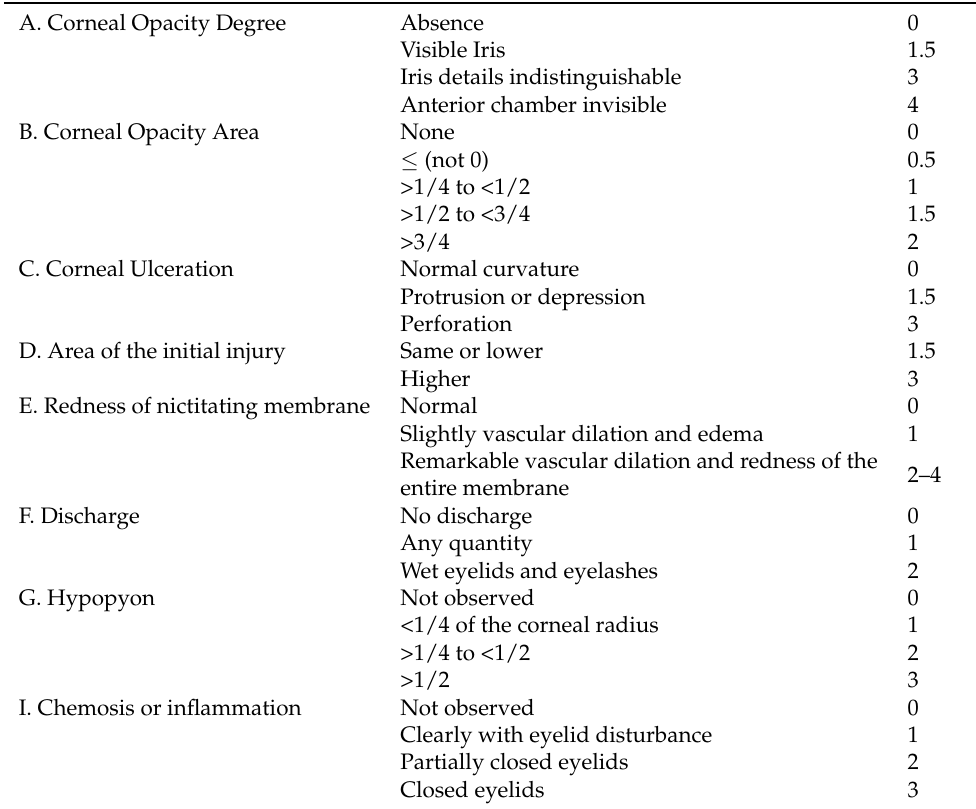
Table 2. Clinical parameters used in the slit-lamp examination score (McDonald–Shadduck scoring